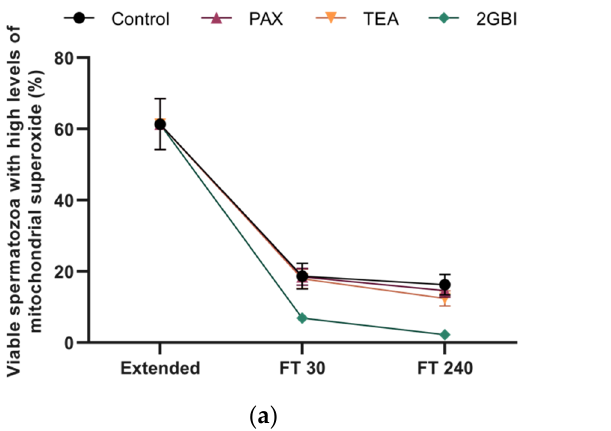
added to LEYGO medium at 5 ◦ C ( b ). Different superscripts indicate significant differences ( P < 0.05) between samples